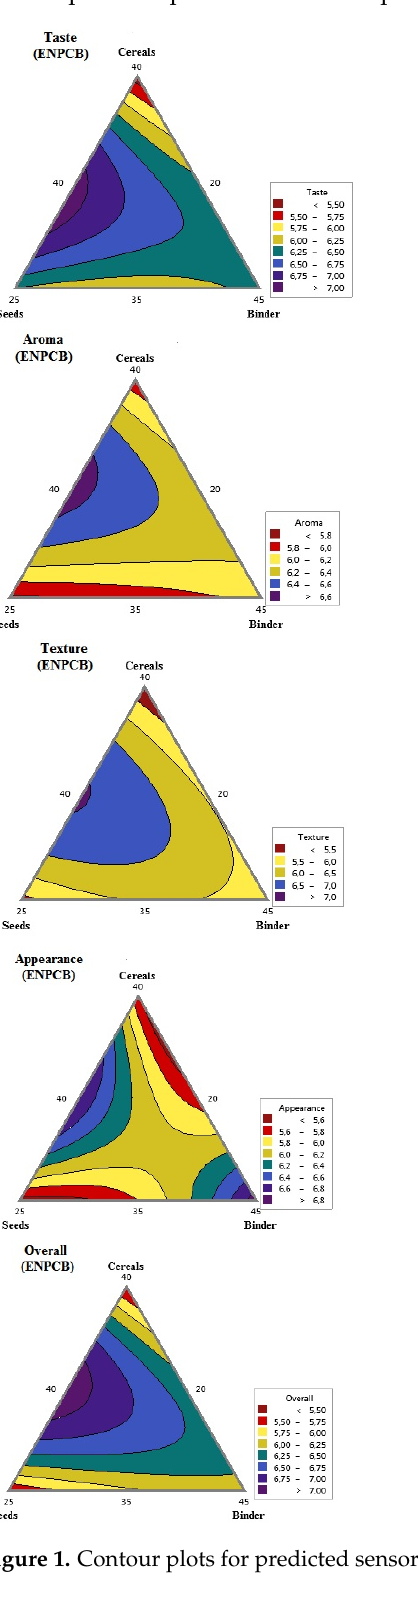
The sensory rating scores for the high-fiber gluten-free cereal bars (Table 5) ranged from dislike to extremely like. Table 5 ′ s findings show that the presence of the three components produced the highest scores for FNPCB, which correspond to F3 producing bars with the best sensory characteristics, with an average score of 7 for taste, 6.4 for texture, 6.6 for appearance, and 6.4 for overall acceptability. The lowest scores ( p < 0.05) were found for F1 with an average score of 4.5 for taste, 4.4 for texture, 5 for appearance, and 4.5 for overall bar acceptability. For FPCB, tasters liked the texture and appearance of the gluten-free bars made by the component of F1, with an average score of 6.4 for texture and 6.2 for appearance. The lowest scores ( p < 0.05) were obtained for F4 and F7 with an average score of 4.9 for taste. Regarding fiber-rich non-puffed cereal bars (FNPCB), for taste and aroma, an opti- mal zone was observed at the level of the central region, with the best scores attributed by tasters, moving towards higher levels in cereals content and lower levels in seeds. The optimum range for texture, appearance, and overall acceptability was noted at around 35g binder (lower binder levels) through the maximum cereal mixture levels for accept- ability and appearance. The region with the lowest levels of cereals had the lowest values of taster scores for all sensory attributes studied (Figure 2). Regarding fiber-rich puffed cereal bars (FPCB), the best taste and aroma scores for fiber-rich bars were found in the area with the highest seed levels. An optimal zone for each parameter was observed on the side with the minimum amount of cereals for tex- ture, appearance, and overall acceptability (Figure 2). The lowest notesweare found in the central region and rise to low binder levels. The different components of each formula have different effects on the sensory pa- rameters of the fiber-rich bars. The form of the cereals used (puffed or non-puffed), the nature of the bonds between the different ingredients, and the presence of psyllium grains with a typical taste are all factors that influence consumer preference.